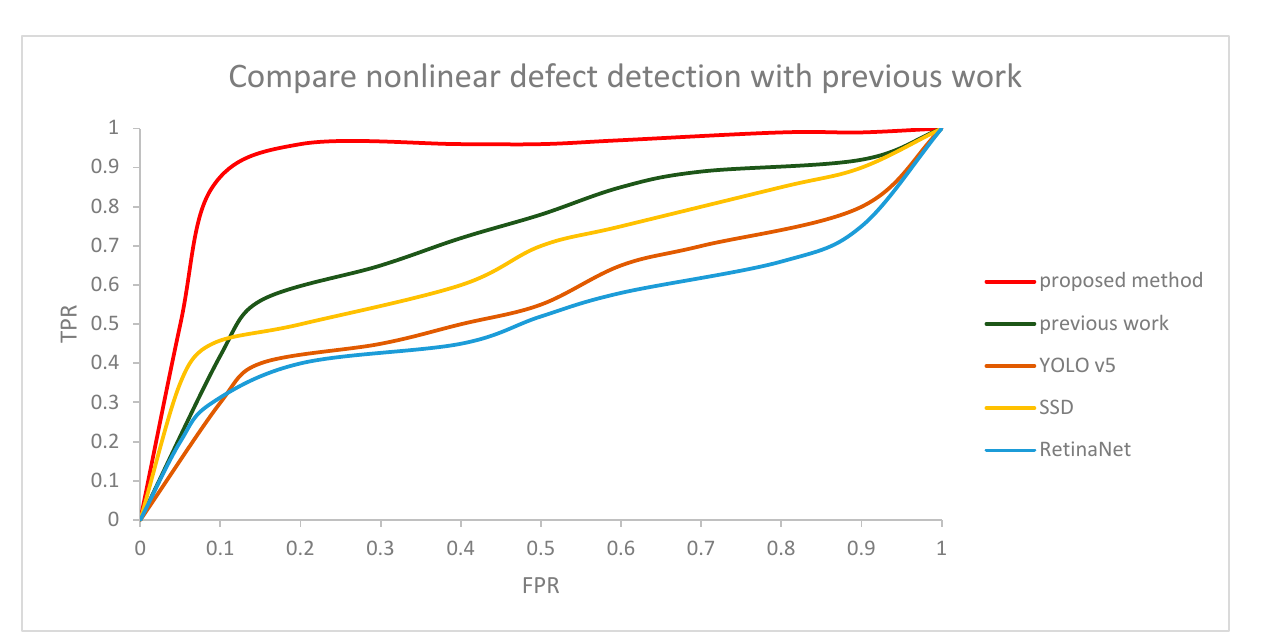
Figure 15. ROC curve for comparing nonlinear defect detection using CNN with previous work.